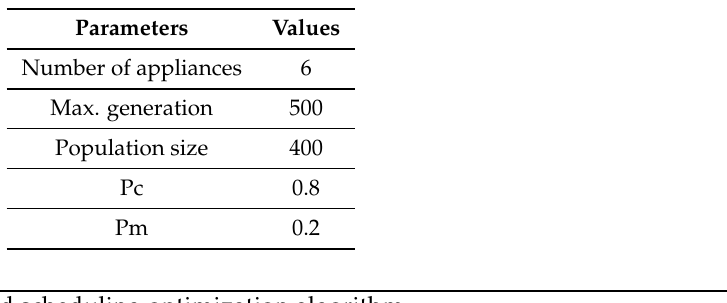
Table 4. Control parameters used in GA [78].